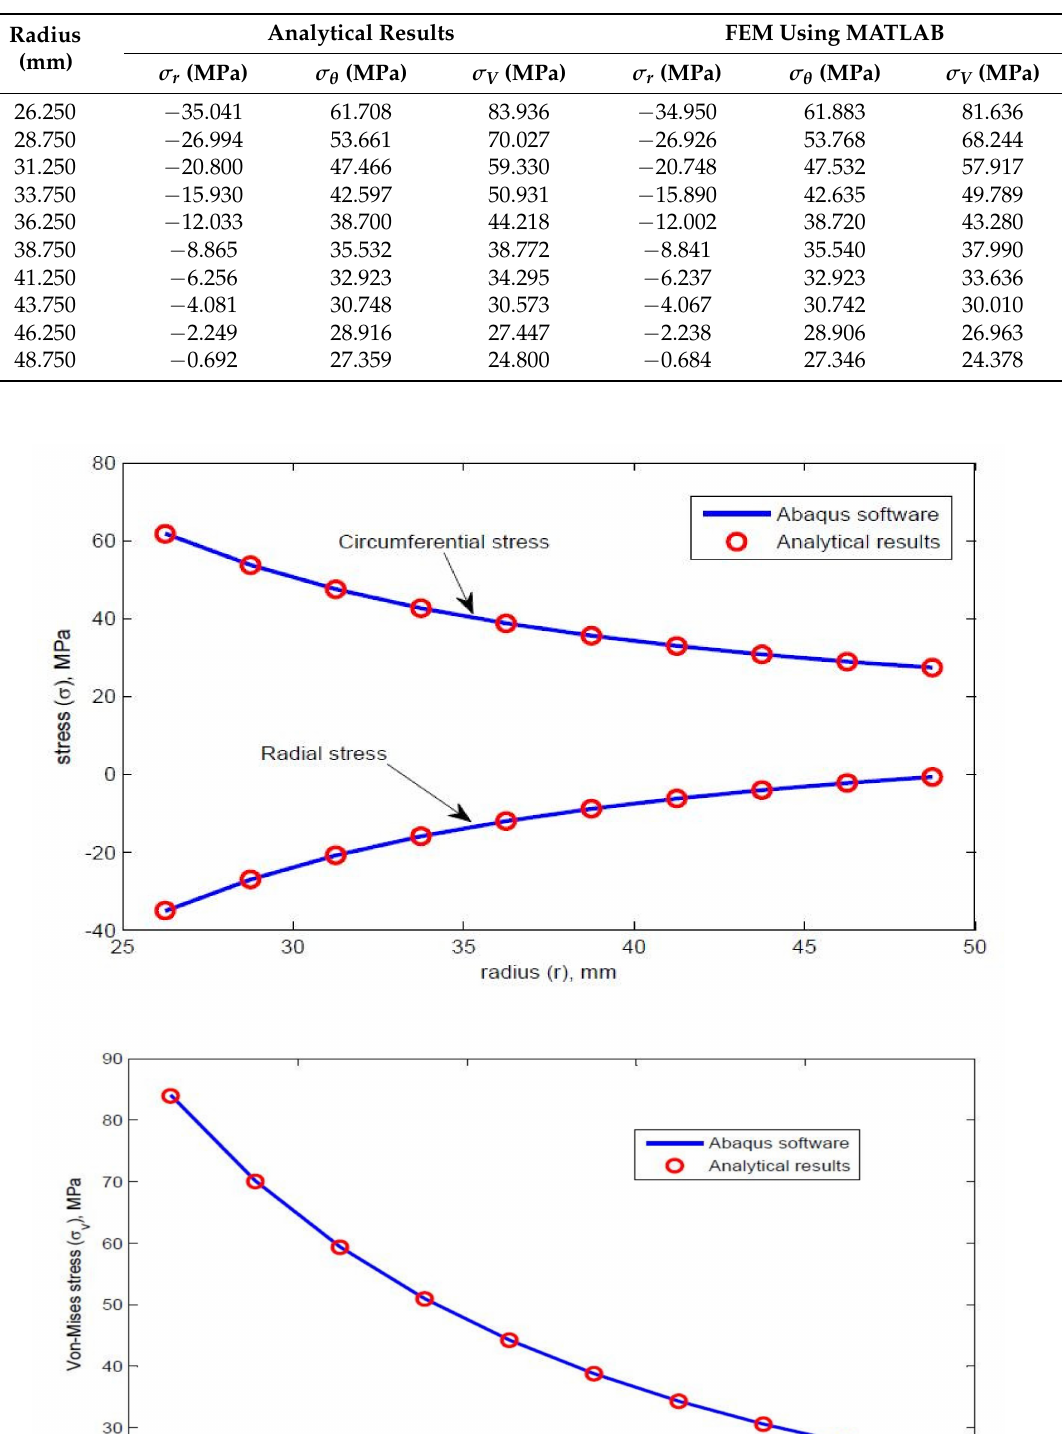
Table 3. Comparison of analytical and FEM using MATLAB results.